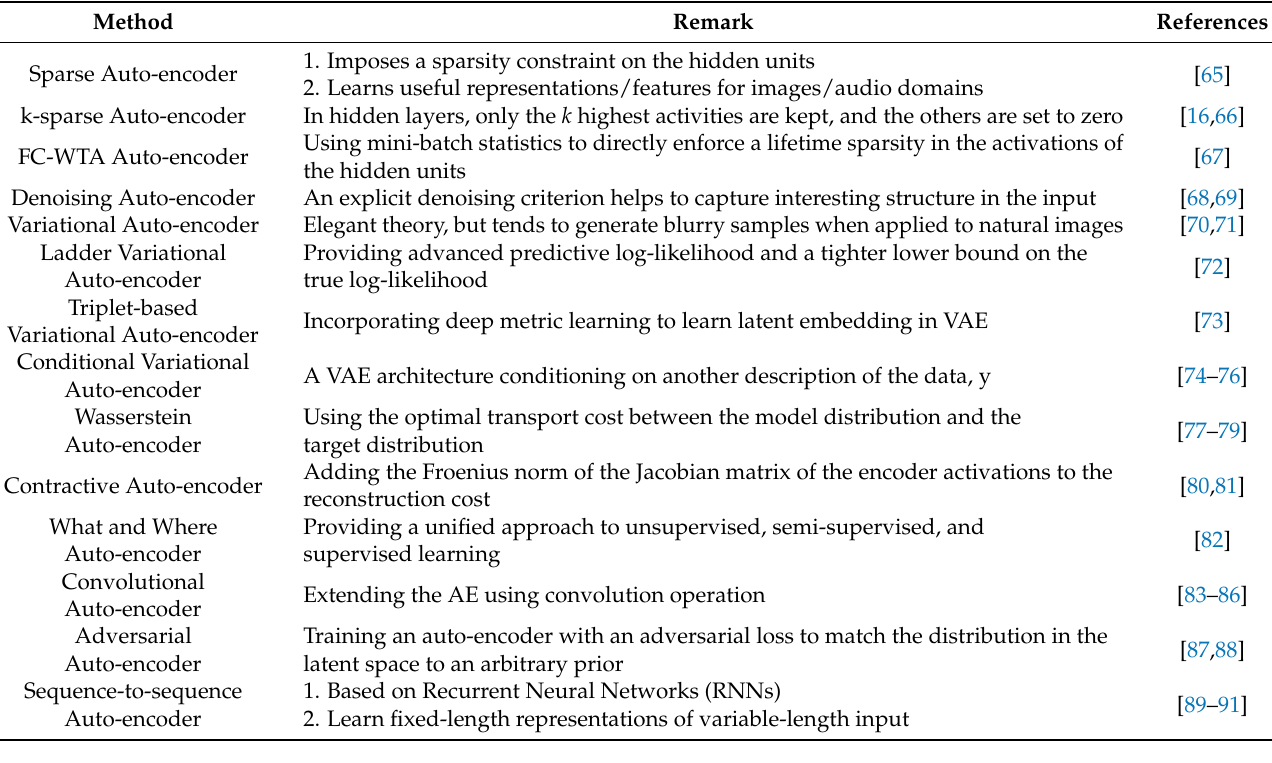
Table 1. Various regularized